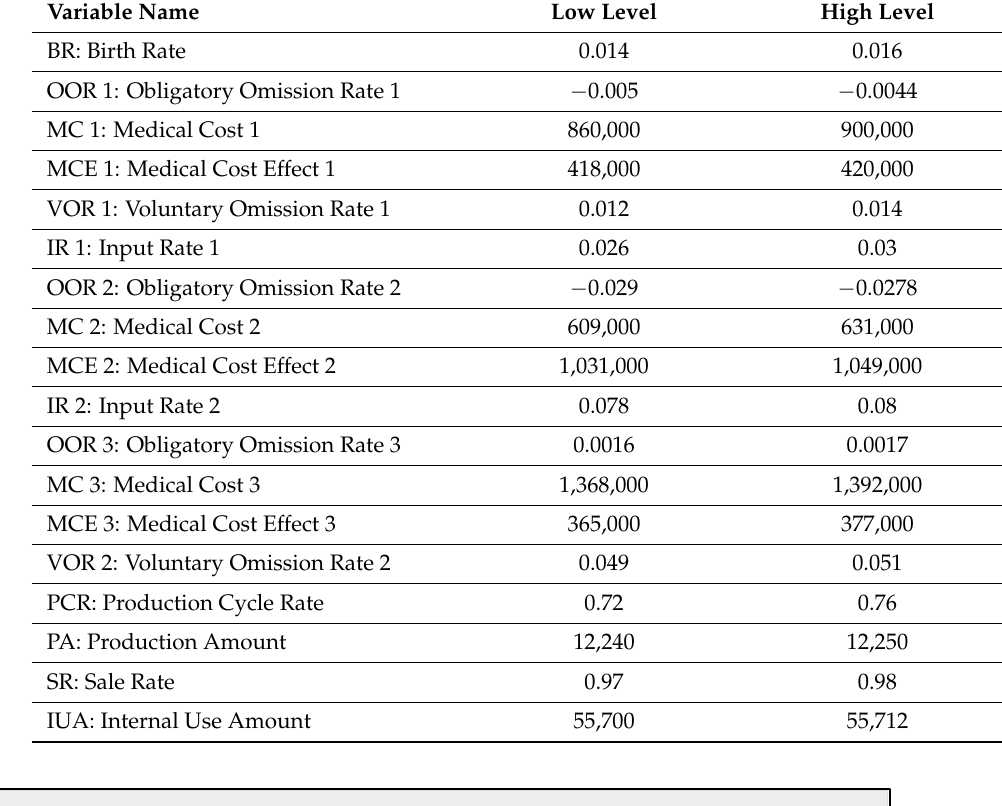
Table 2. High and low levels of auxiliary variables.